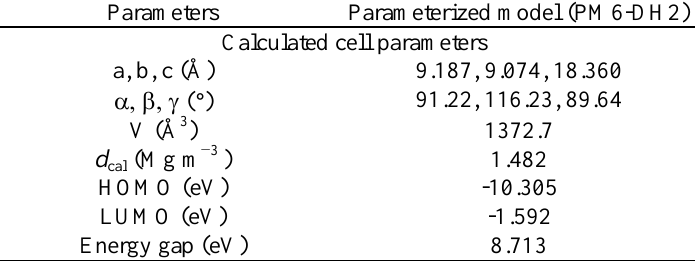
Table 3. Theoretically computed structural and energy